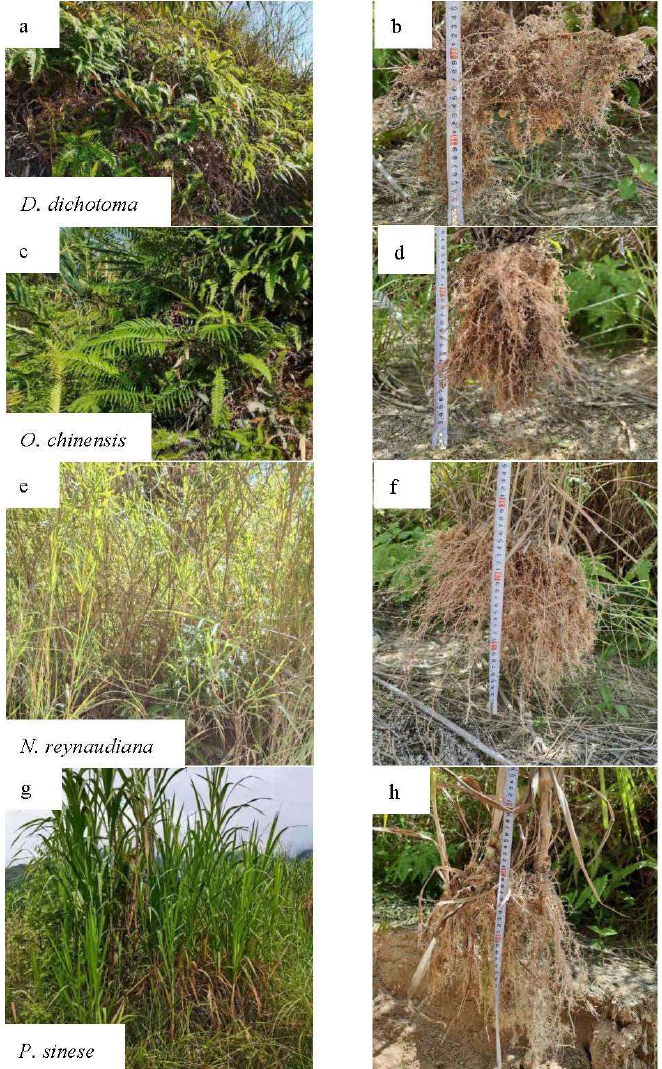
Figure 2. ( a ) Growth of Dicranopteris dichotoma ; ( b ) Root system of Dicranopteris dichotoma ; ( c ) Growth of Odontosoria chinensis ; ( d ) Root system of Odontosoria chinensis ; ( e ) Growth of Neyraudia reynaudiana ; ( f ) Root system of Neyraudia reynaudiana ; ( g ) Growth of Pennisetum sinese ; ( h ) Root system of Pennisetum sinese .